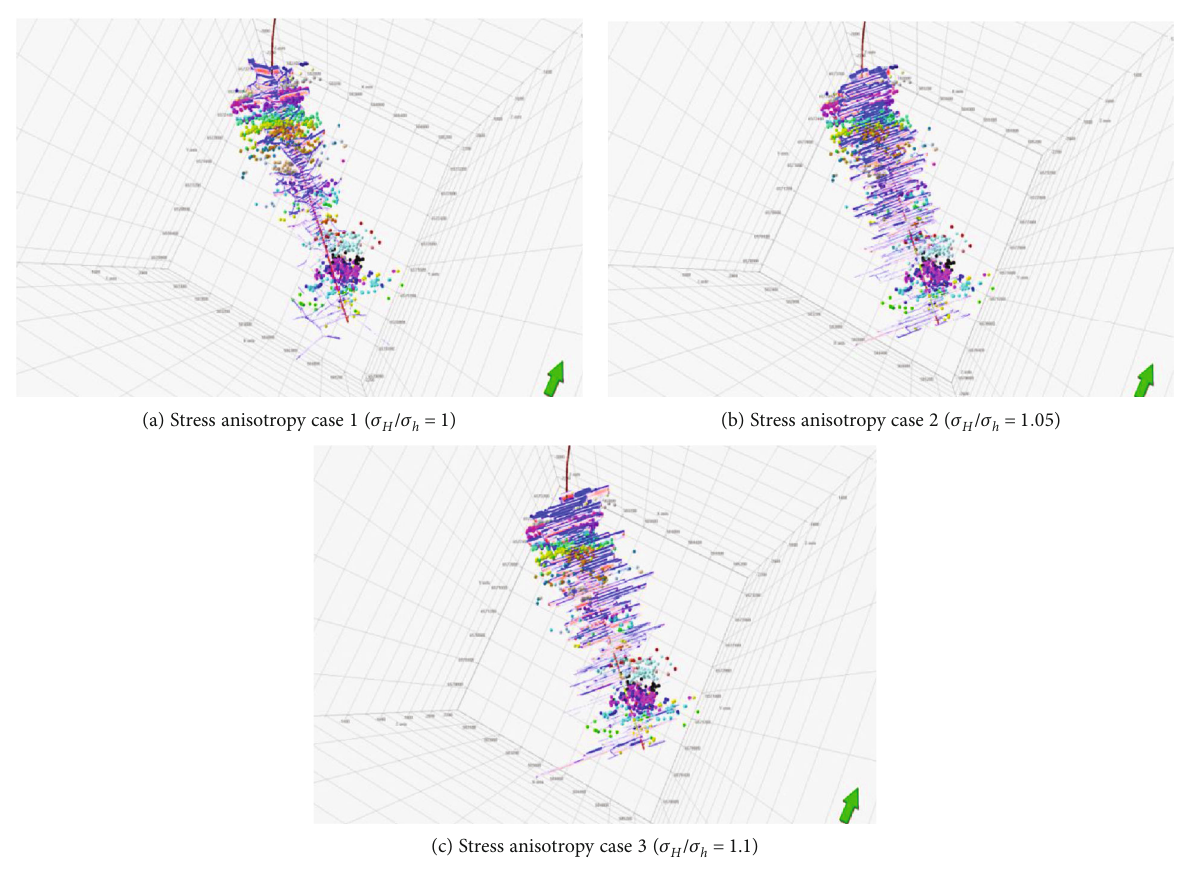
Figure 10: Fracture simulation results of di ff erent stress anisotropies.